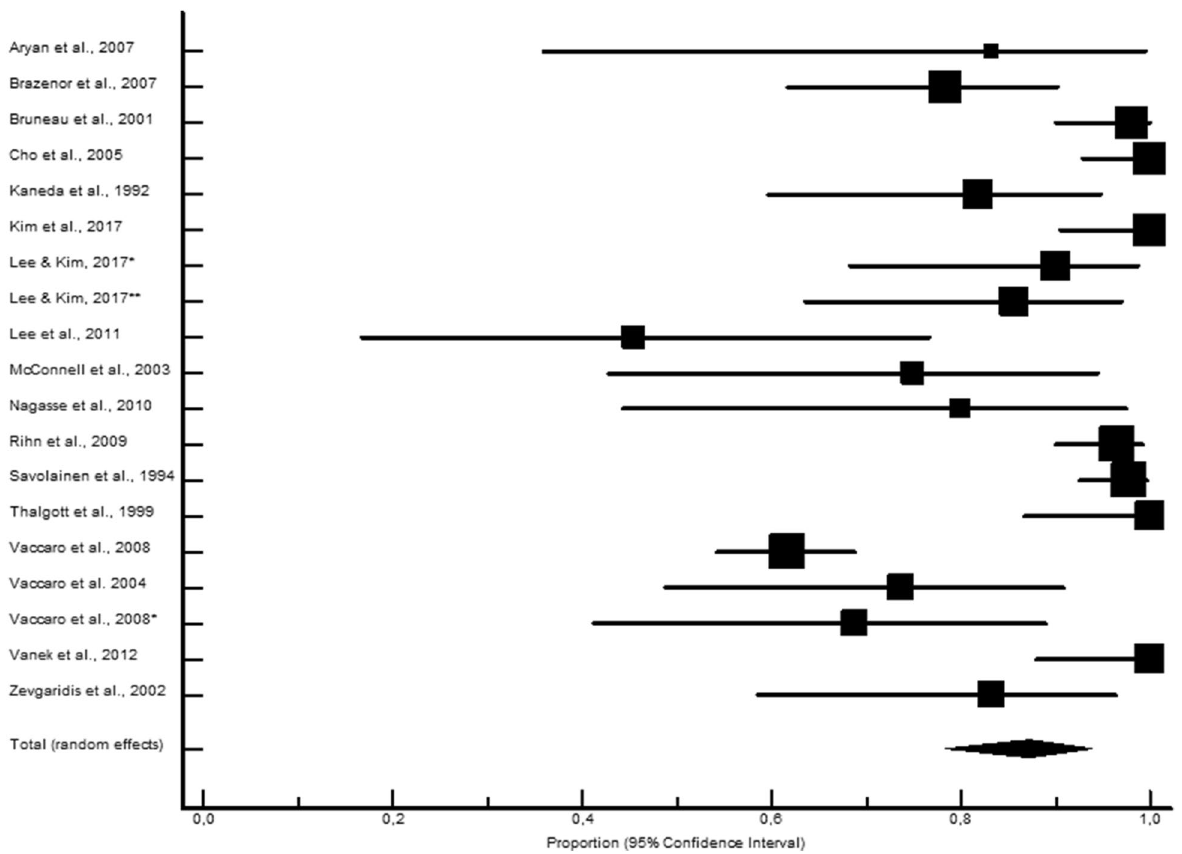
Figure 4. Alloplastic pooled proportional rate for spinal